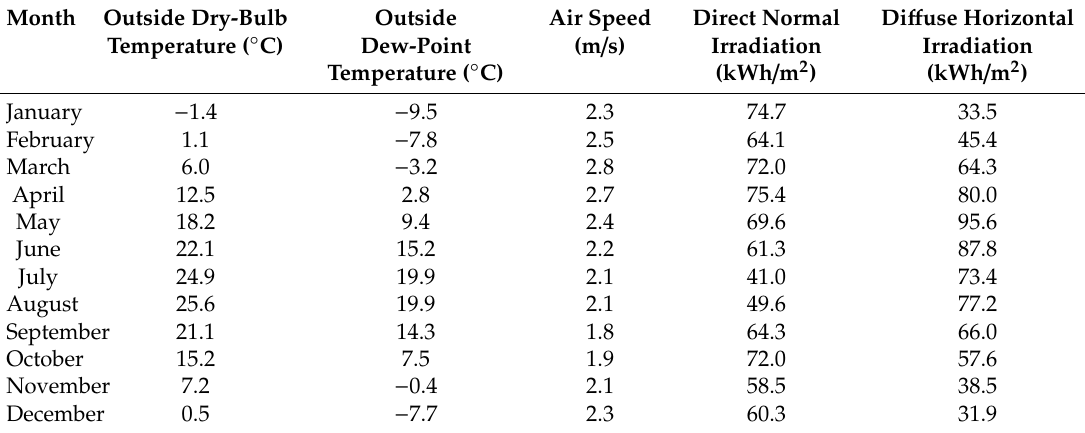
Table 2. Weather conditions.